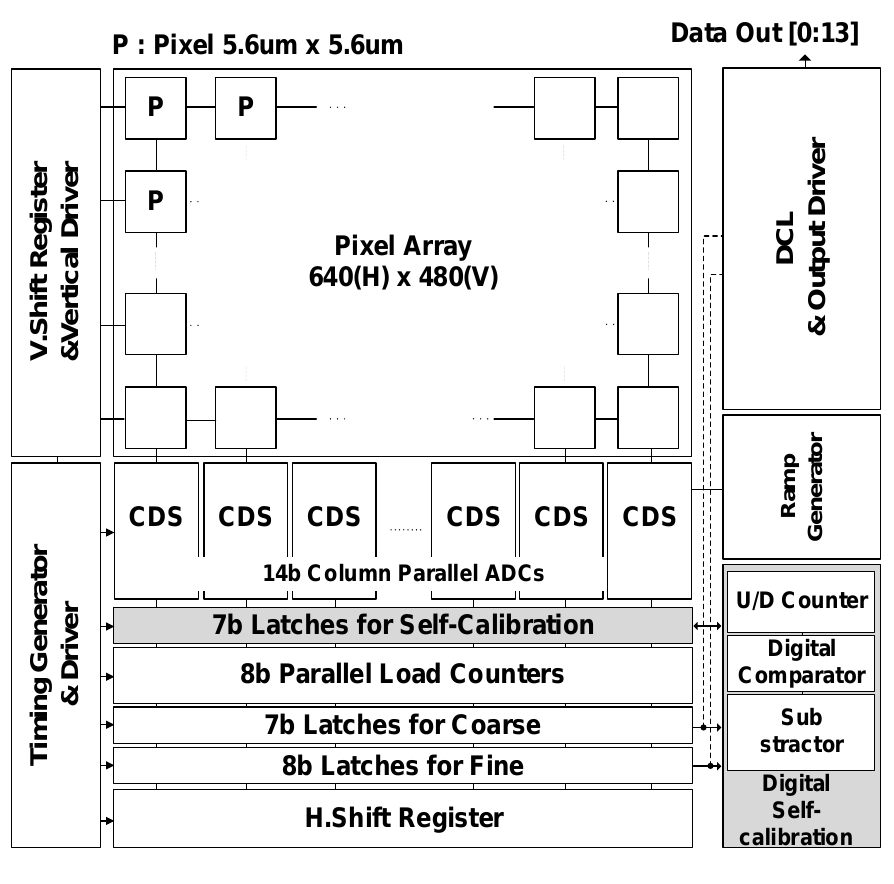
Figure 5. Structure of the CMOS image sensor with the 14-bit TS SS